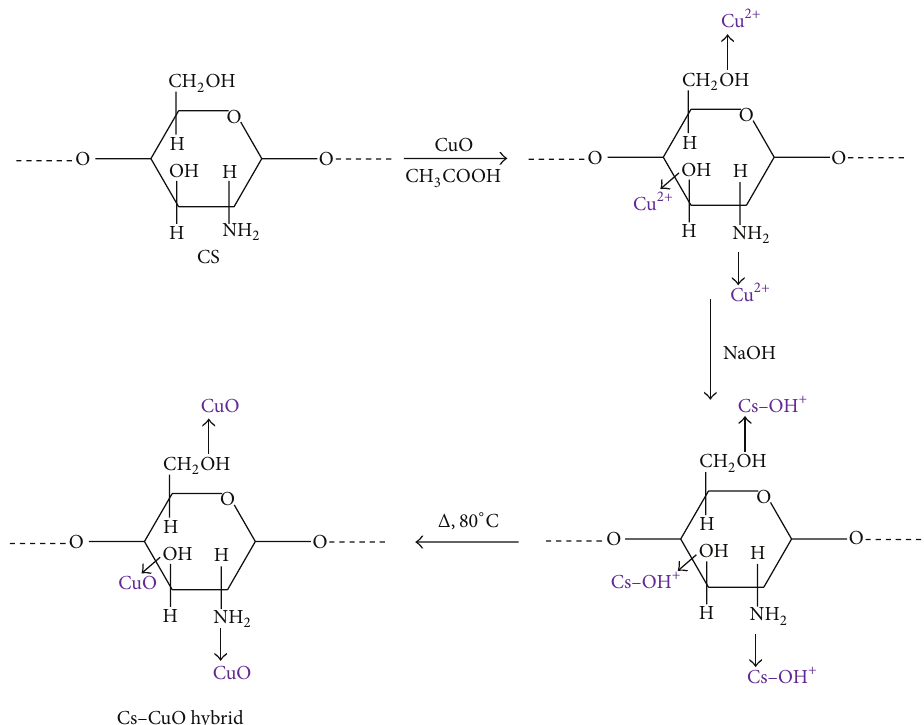
Scheme 1: Schematic representation for the synthesis of CS-CuO